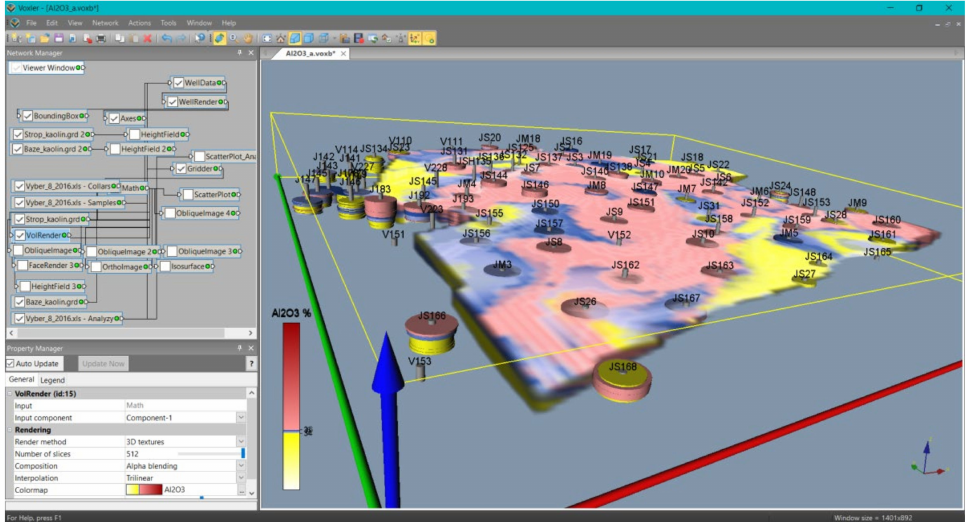
Figure 13. Three-dimensional visualization of the Al 2 O 3 content—Plotting the 3D grid using